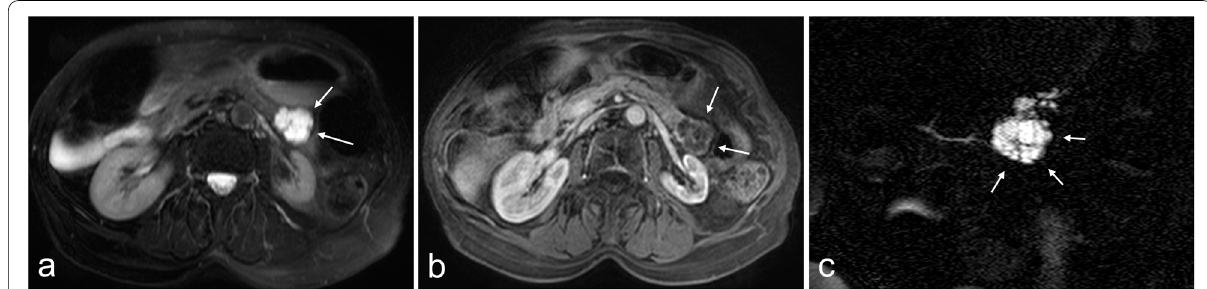
Fig. 1 Pancreatic MRI performed 13 years earlier showed a typical pancreatic microcystic serous cystadenoma in the tail of pancreas. a Axial T2‑weighted image. Well‑defined, homogeneous, high T2 signal intensity, polycystic components (arrows). b Axial T1‑weighted image after gadolinium chelates (Dotarem ® ) injection. Isolated septa enhancement (arrows). c Radial MR cholangiopancreatography. Honeycomb pattern